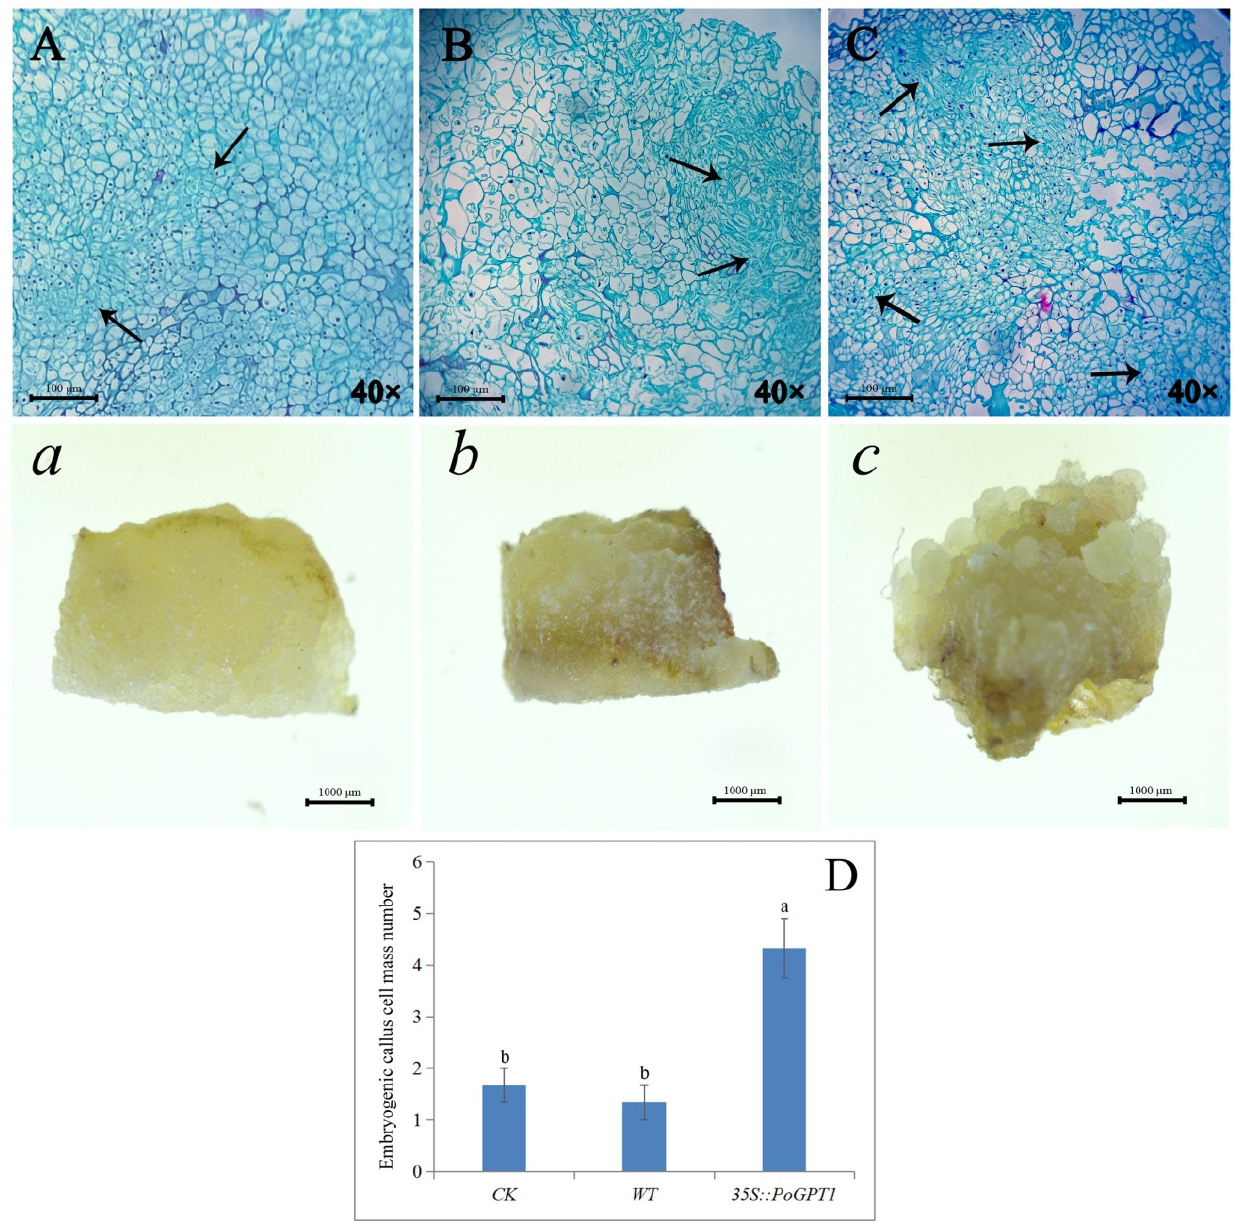
Figure 6. Phenotypic observation, paraffin-embedded sections and of PoGPT1 -overexpressing transgenic callus of tree peony (( A ), ( a ), WT: nontransformed callus; ( B ), ( b ), CK: pCAMBIA1302; ( C ), ( c ), 35s::PoGPT1 ; ( D ): Embryogenic callus cell mass quantitative analysis. Vertical bars indicate standard error ( n = 3). Different letters indicate significant differences using the Duncan’s Multiple Range Test ( p ≤ 0.05). Black arrow indicates embryogenic callus mass. Scale bar: 100 μ m, 1000 μ m).